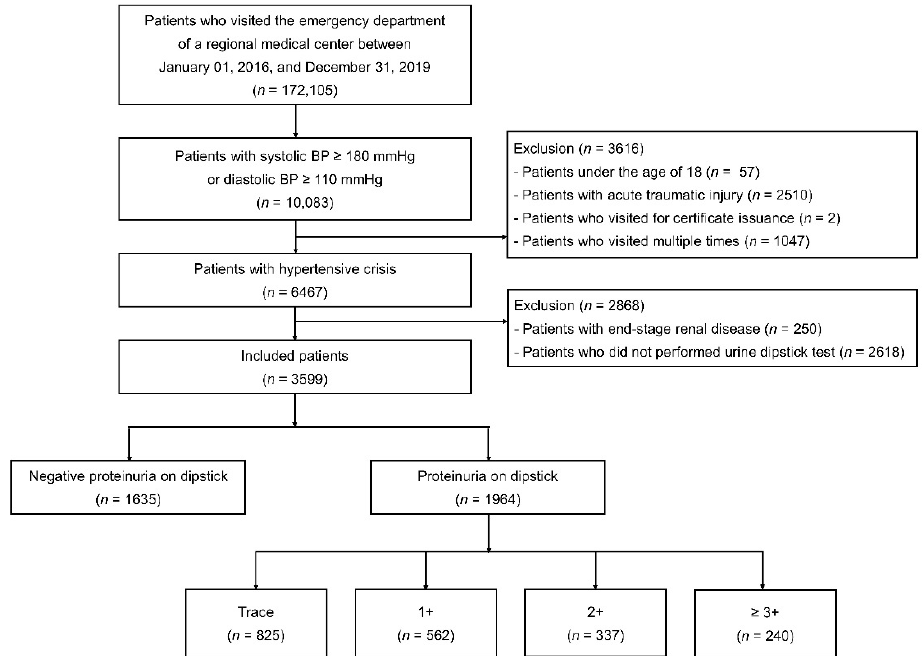
Figure 1. Flow diagram illustrating patients with a hypertensive crisis who were included in this study. BP, blood pressure.